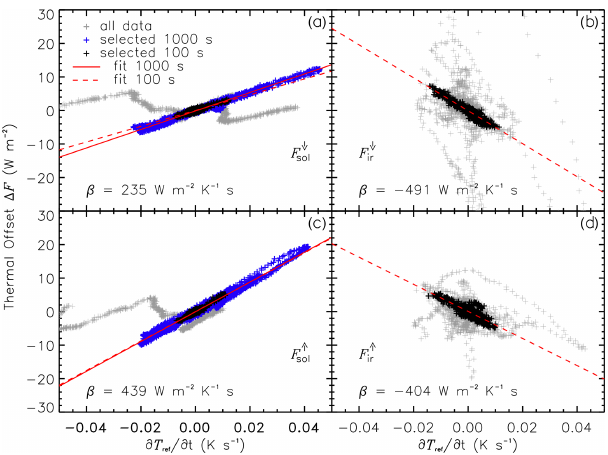
Figure 5. Dynamic thermal offset (cid:49)F as a function of the rate of temperature change for both pyranometers in terms of downward solar irradiance (a) and upward solar irradiance (c) as well as both pyrgeometers in terms of downward thermal–infrared irradiance (b) and upward thermal–infrared irradiance (d) . Gray symbols show all data from the night flight on 15 May 2019 (about 1.5h). For the selected and detrended data (1000 and 100s high-pass filter), linear regressions and the thermal offset correction coefficient β (only for 100s high-pass filter) are added.